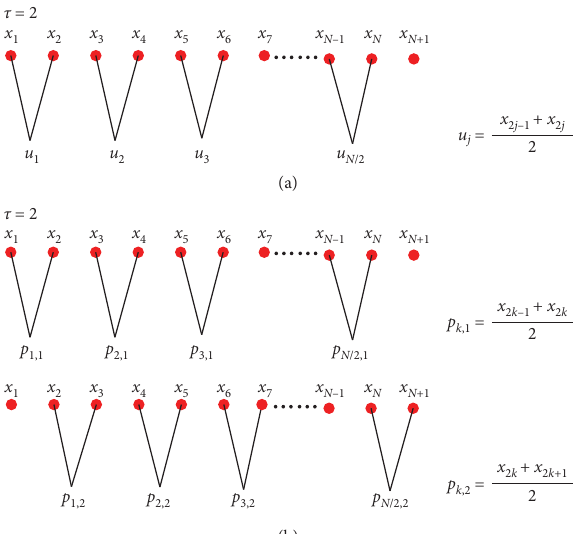
Figure 2: Two different coarse-graining methods. (a) The traditional coarse-graining method when τ � 2. (b) The sliding coarse-graining method when τ � 2.